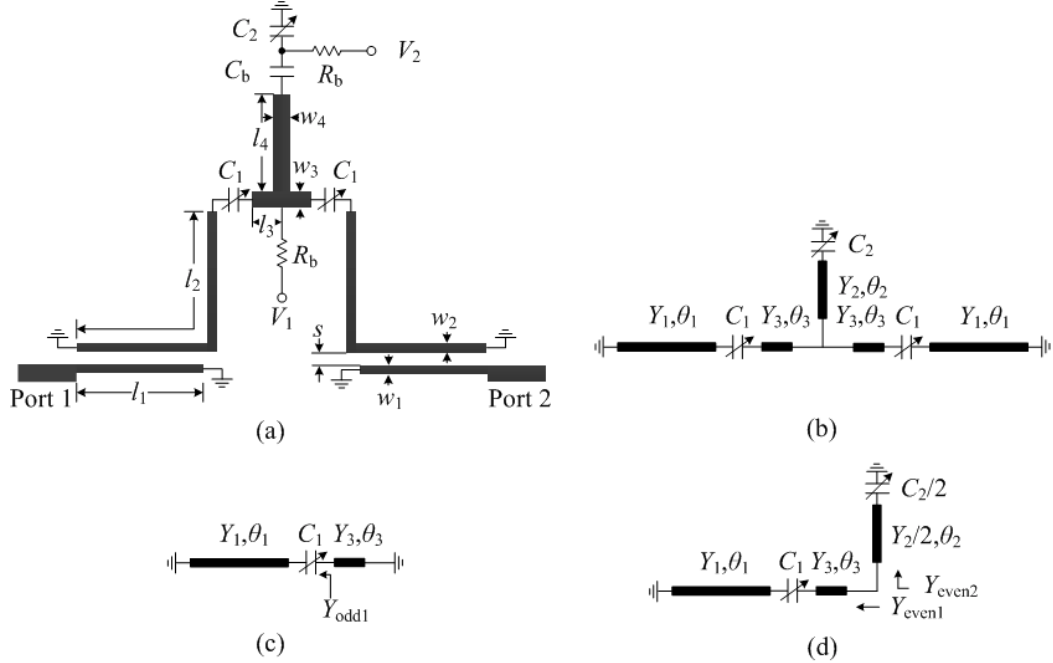
Figure 1. ( a ) Schematic diagram of the proposed filter; ( b ) transmission line mode; ( c ) odd mode; and ( d ) even mode.